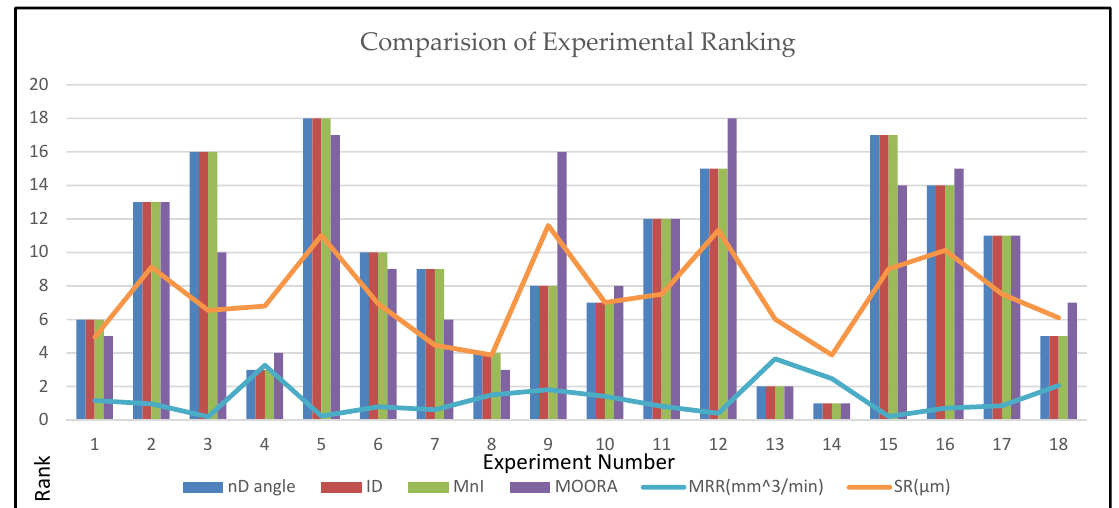
Figure 4. Comparison of optimization methods w.r.t. experimental ranking and output parameters.